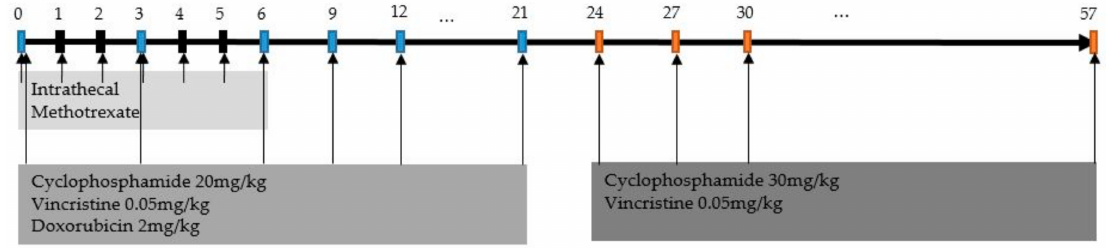
Figure 1. Flowchart of the CVDM